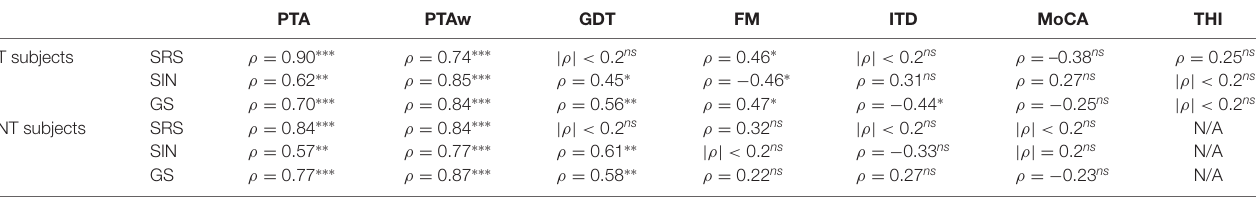
TABLE 1 | Correlations of speech comprehension ability with other audiometric parameters in the T and NT groups.